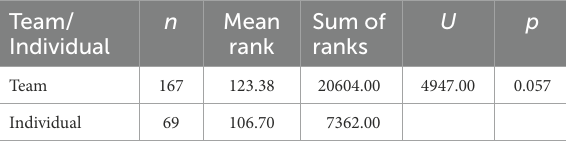
TABLE 3 Mann–Whitney U test results concerning the training and instruction sub-dimension.